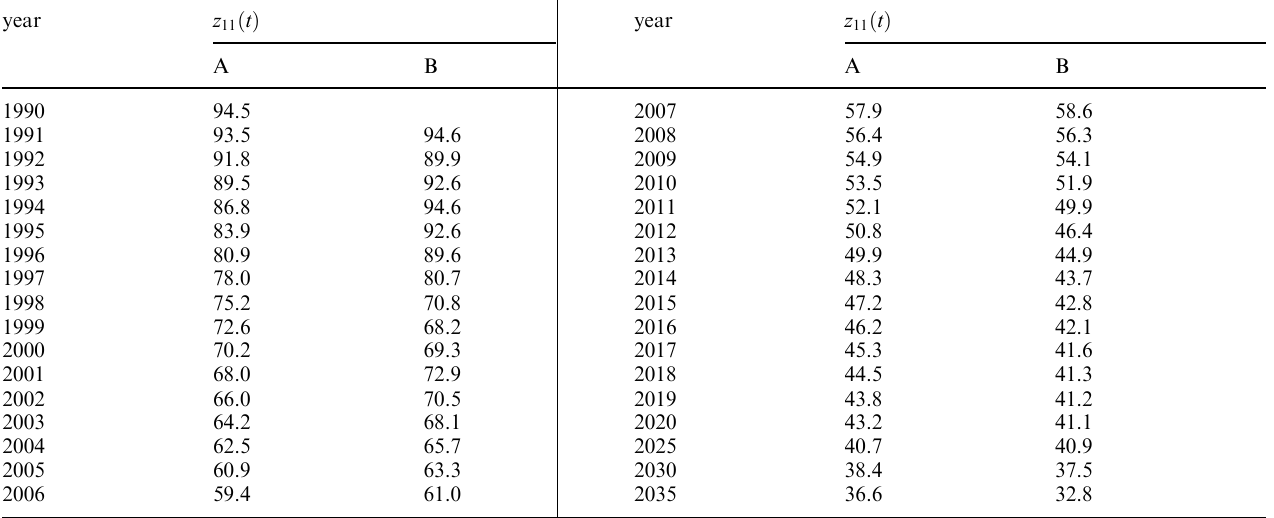
Table 2. z 11 (cid:133) t (cid:134)